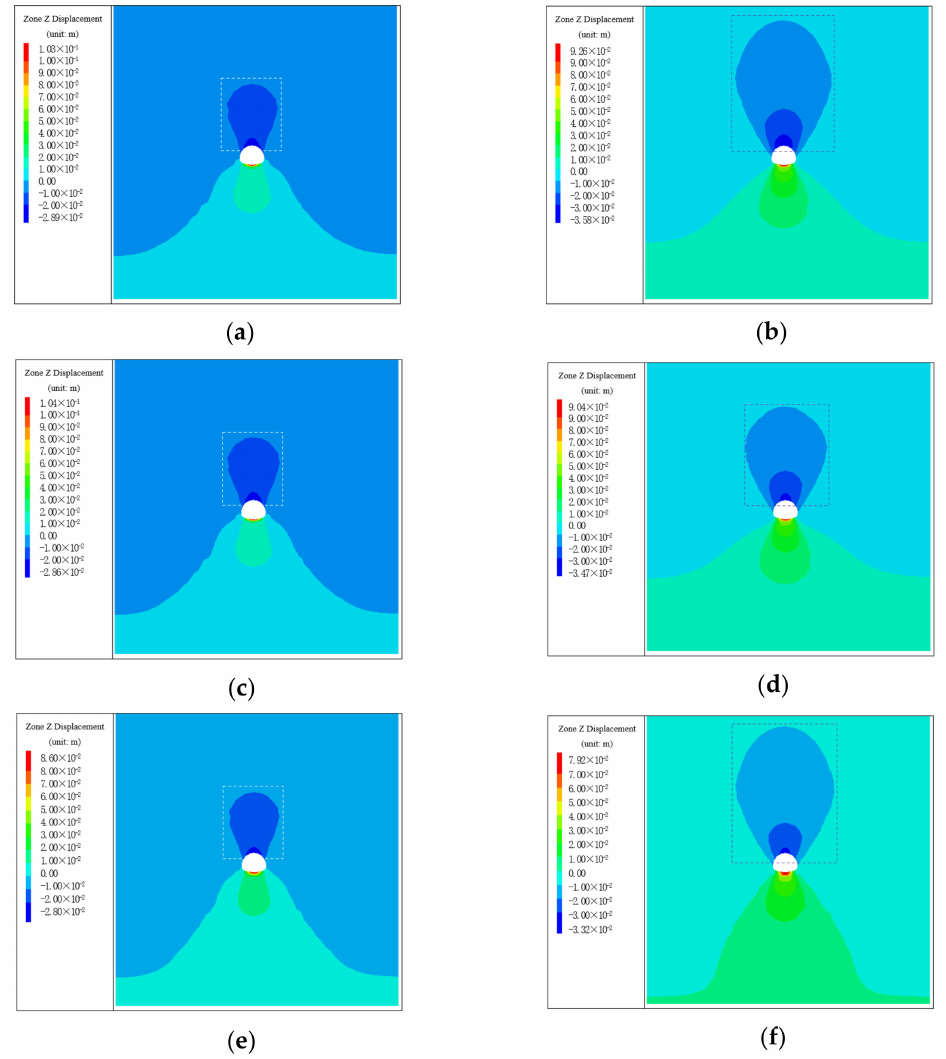
Figure 6. Cloud diagram of the vertical displacement at a 60 m buried depth. ( a ) Cloud diagram of the vertical displacement under Grade IV surrounding rock and 1/4 ring grouting; ( b ) Cloud diagram of the vertical displacement under Grade V surrounding rock and 1/4 ring grouting; ( c ) Cloud diagram of vthe ertical displacement under Grade IV surrounding rock and 1/2 ring grouting; ( d ) Cloud diagram of the vertical displacement under Grade V surrounding rock and 1/2 ring grouting; ( e ) Cloud diagram of the vertical displacement under Grade IV surrounding rock and full-ring grouting; ( f ) Cloud diagram of the vertical displacement under Grade V surrounding rock and full-ring